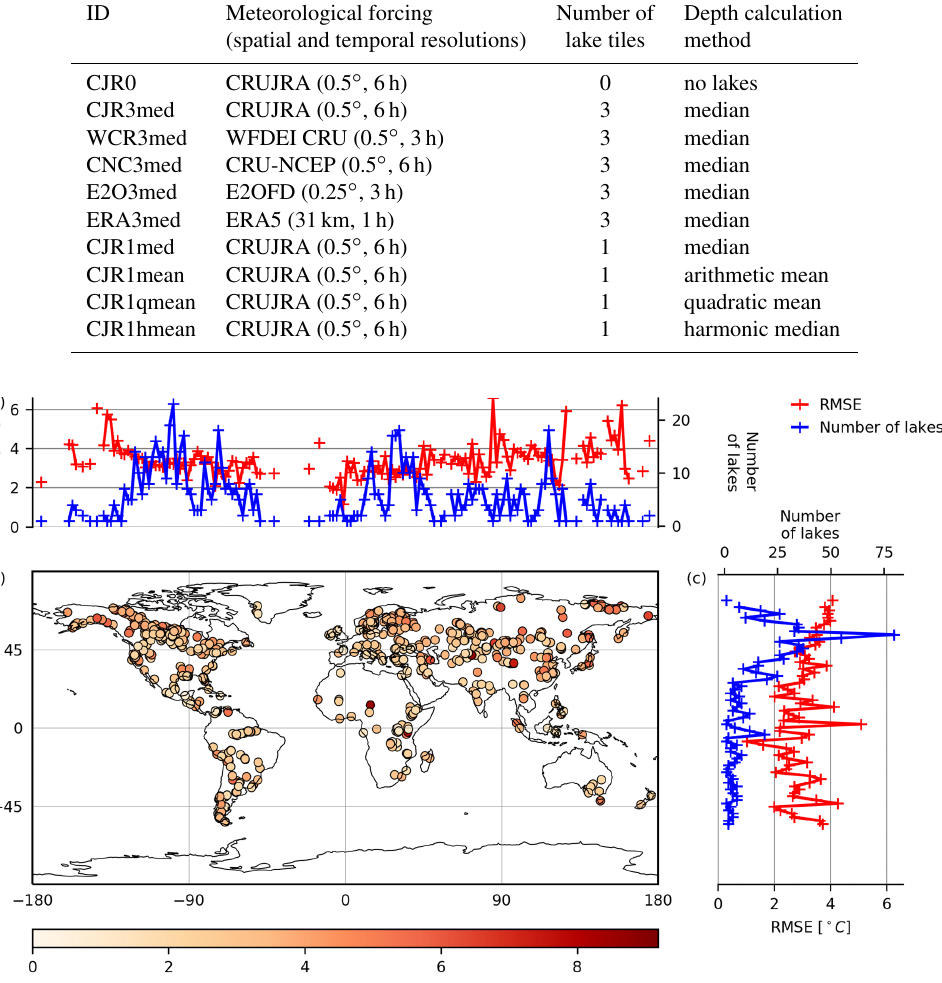
Figure 3. LSWT errors (RMSEs) simulated by ORCHIDEE-FLake in the CJR3med configuration run at 0.5 ◦ resolution. Longitudinal (a) and latitudinal (c) averages of the RMSEs (in red) and number of lakes observed in GloboLakes (in blue) are plotted along the map.